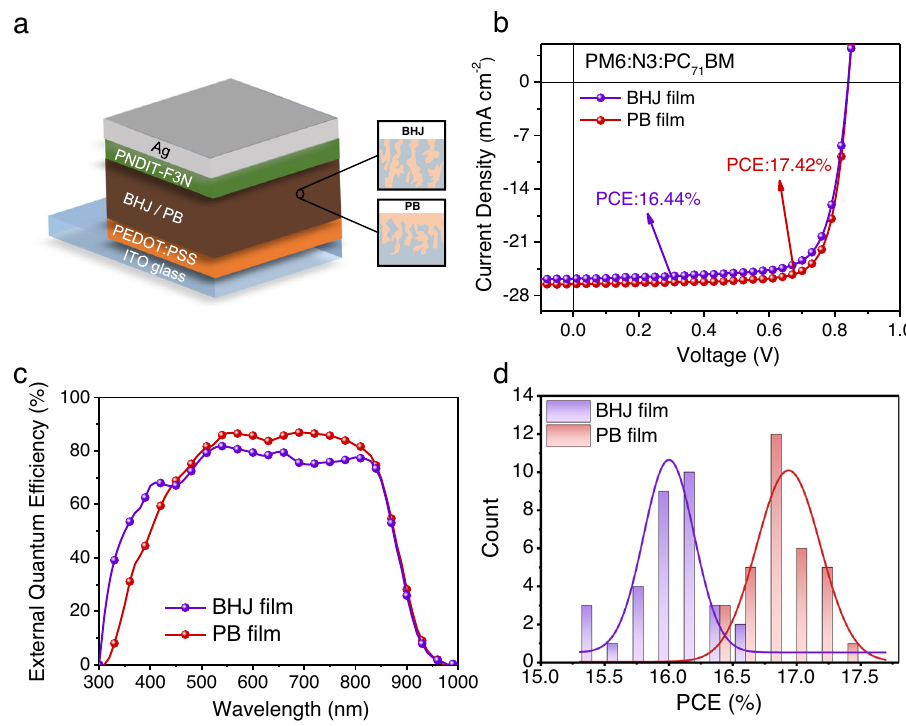
Fig. 3 Device structure and performance. a Schematic of OSC structure. b J – V curves of the OSCs with BHJ and PB architectures under 1 sun illumination. c EQE spectra of the BHJ and PB OSCs. d PCE histograms of BHJ and PB OSCs. Table 1 The performance parameters of the champion devices of BHJ and PB